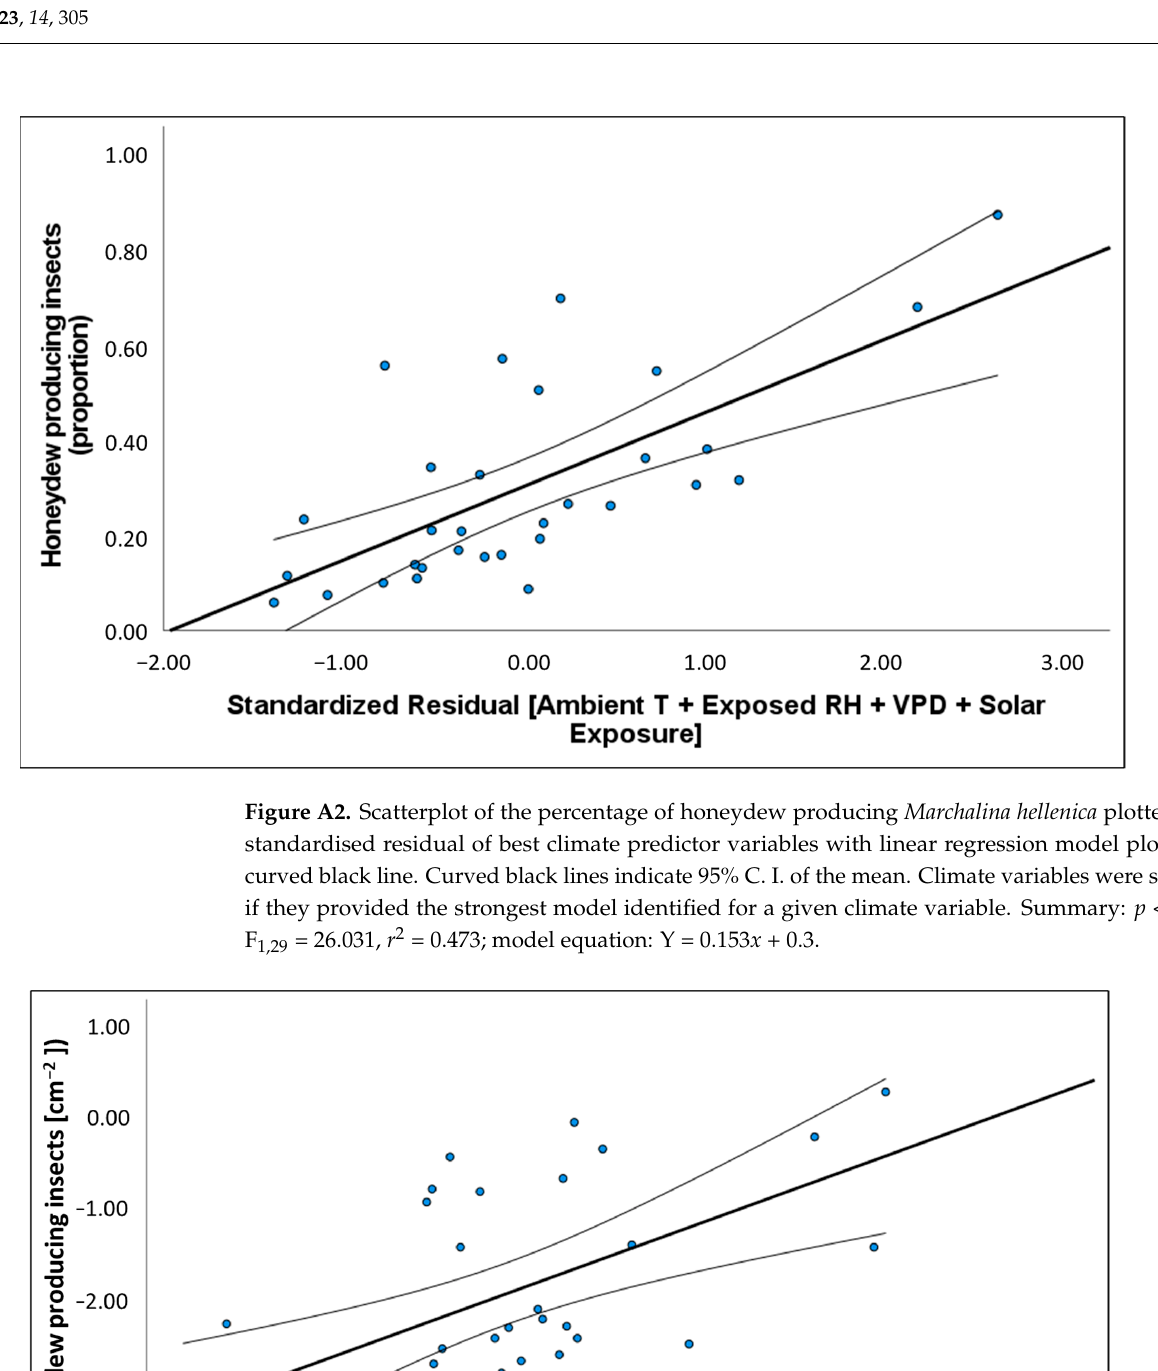
19 of 24 Table A10. Summary of climate regression models predicting the percentage of honeydew produc- ing Marchalina hellenica . Climate records used in models represent the fortnightly mean value of daily maximum, except rainfall; recorded cumulatively in millimetres. N = 30 for each regression analyses. Predictor